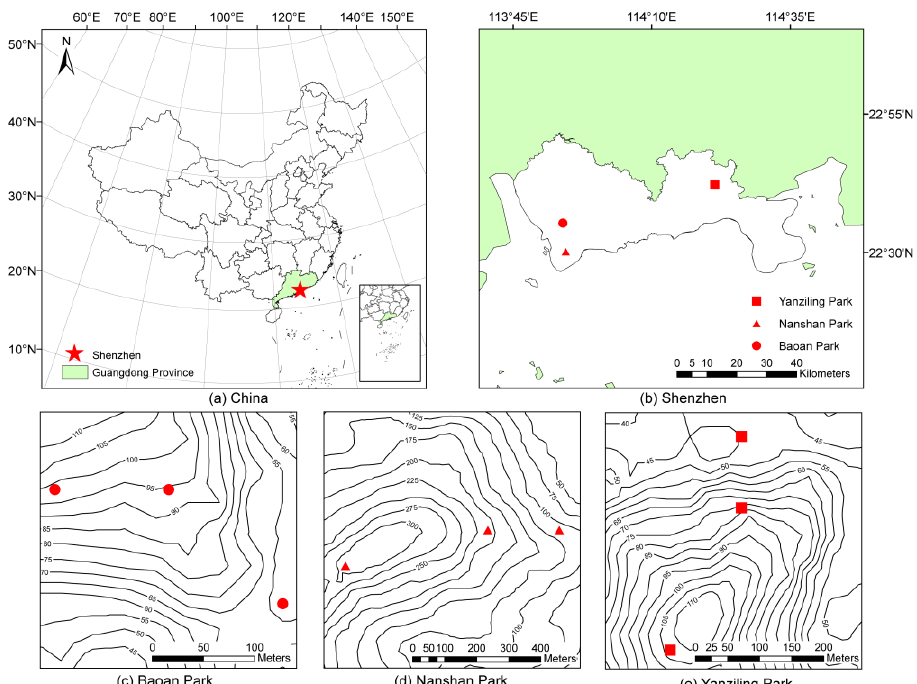
Figure 1. ( a ) Location of Shenzhen within China; ( b ) locations of three urban parks within Shenzhen; ( c ) distribution of sampling sites in Baoan Park; ( d ) distribution of sampling sites in Nanshan Park; ( e ) distribution of sampling sites in Yanziling Park. (Produced using ArcMap 10.2. Exact values for altitudes are specified in Table S1.)